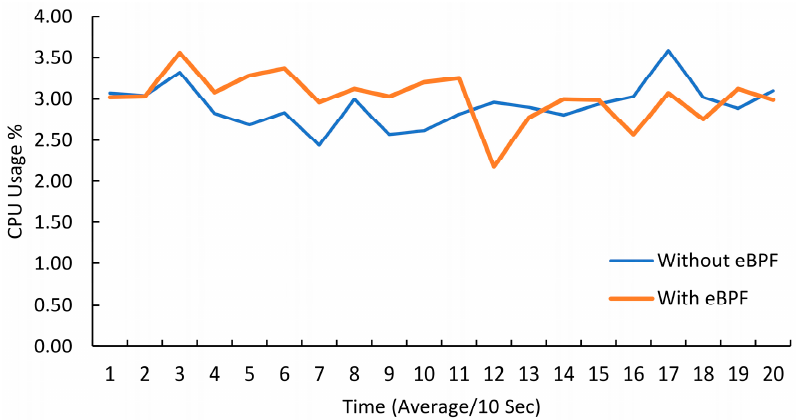
Figure 4. Master Node CPU Overhead Analysis.